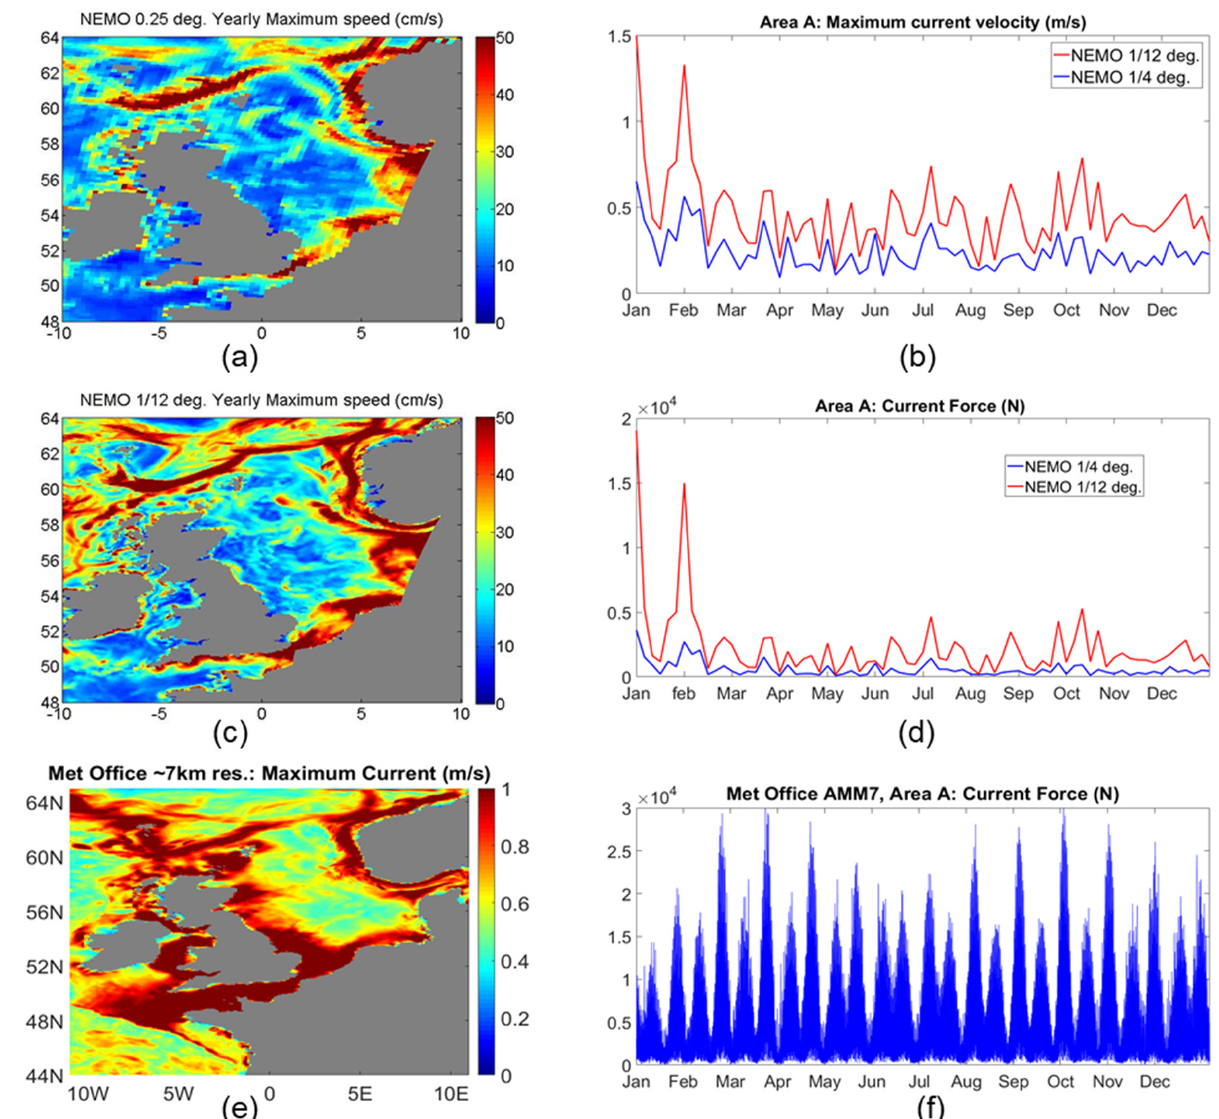
Figure 16. Spatial maps of yearly maximum current velocity from NOCS NEMO model at spatial resolution of 0.25° (ORCA025) ( a ) and 1/12° (ORCA12) ( c ). Time series of maximum current velocity (m/s) ( b ) and Current force (N) ( d ) for Area A, from ORCA12 (red) and ORCA025 (blue). Map of maximum yearly current velocity (m/s) ( e ) and time series of current Force (N) ( f ) from Met Office FOAM AMM7 (~7 km resolution).